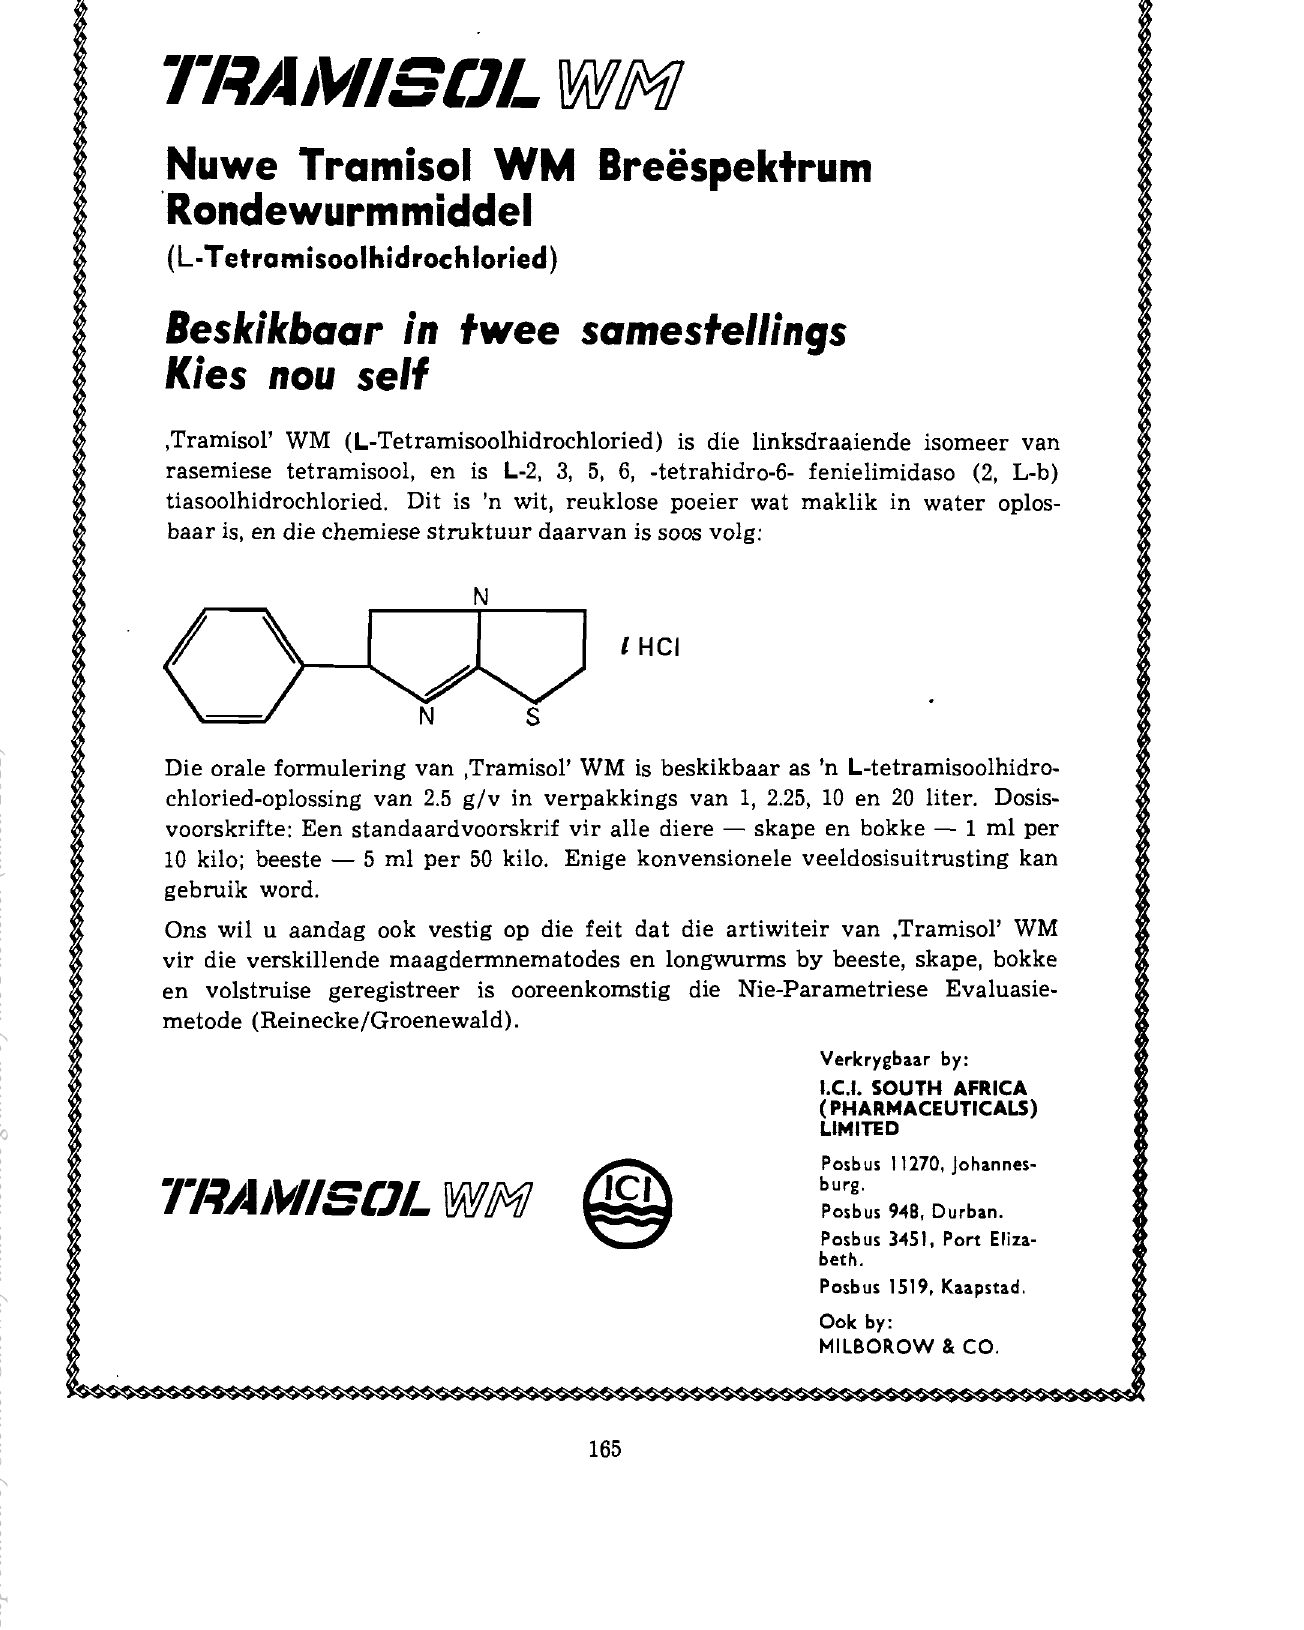
,Tramisol' WM (L-Tetramisoolhidrochloried) is die linksdraaiende isomeer van rasemiese tetramisool, en is L-2, 3, 5, 6, -tetrahidro-6- fenielimidaso (2, L-b) tiasoolhidrochloried. Dit is 'n wit, reuklose poeier wat maklik in water oplos baar is, en die chemiese struktuur daarvan is soos volg: N o c ; l J I Hel N S Die orale formulering van ,Tramisol' WM is beskikbaar as 'n L-tetramisoolhidro chloried-oplossing van 2.5 g/v in verpakkings van 1, 2.25, 10 en 20 liter. Dosis voorskrifte: Een standaardvoorskrif vir aIle diere - skape en bokke - 1 ml per 10 kilo; beeste - 5 ml per 50 kilo. Enige konvensionele veeldosisuitrusting kan gebruik word. Ons wil u aandag ook vestig op die feit dat die artiwiteir van ,Tramisol' WM vir die verskillende maagdermnematodes en longwurms by beeste, skape, bokke en volstruise geregistreer is ooreenkomstig die Nie-Parametriese Evaluasie metode